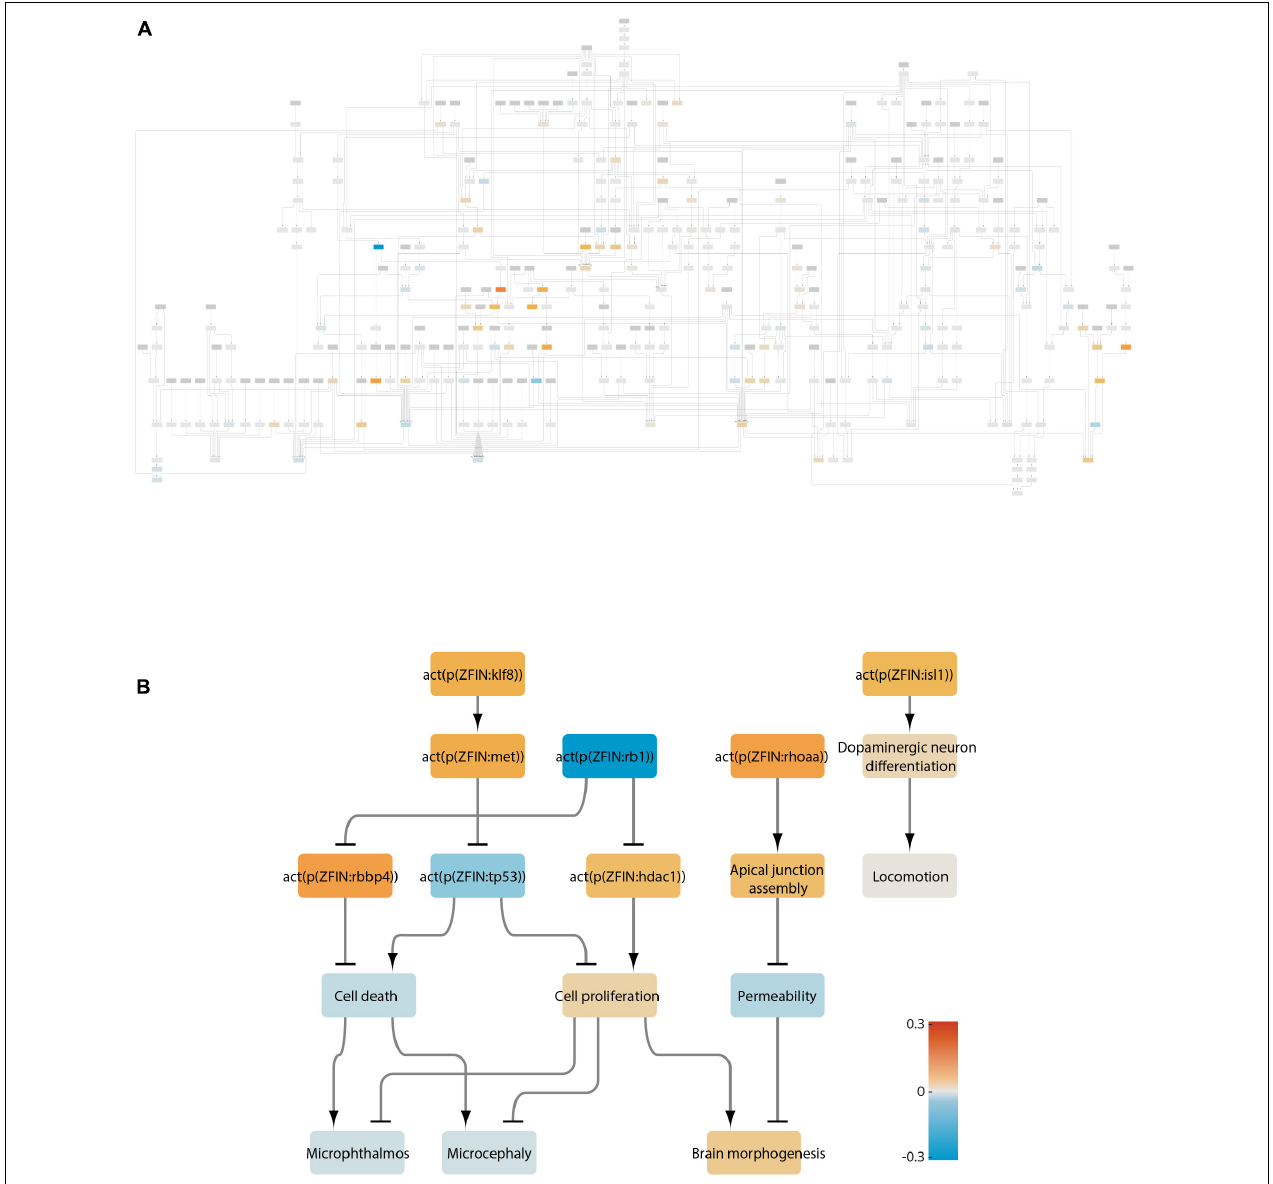
FIGURE 4 | Neurotoxicity network scored with the transcriptome of rb1 mutant larvae. (A) Visualization of the affected nodes in the network. Increased and reduced activity for each node is color-coded according to the heatmap. (B) Leading nodes extracted from A into a